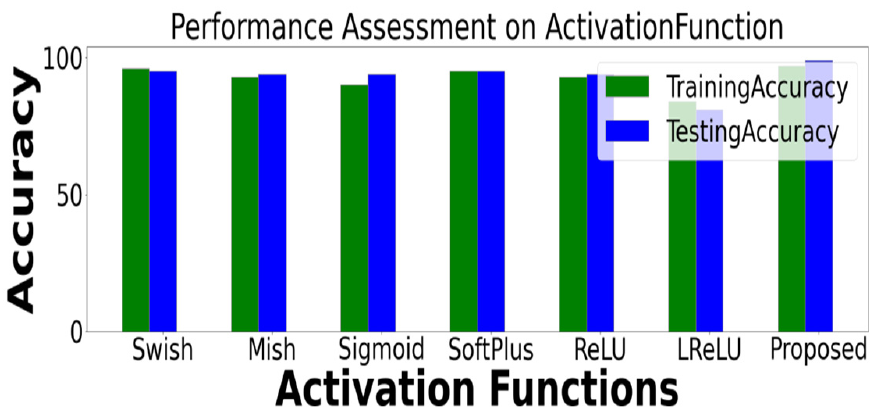
Figure 4. In the diabetic retinopathy model, the proposed activation function gives the most accurate results for the dense layers. Compared to ReLu, LReLu, Sigmoid, and Softplus, Mish and Swish’s activation functions provide a near-consistent improvement.